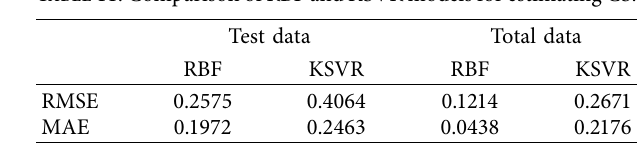
Figure 13: Actual and predicted values of ITS by the RBF and KSVR models for total data. Table 11: Comparison of RBF and KSVR models for estimating